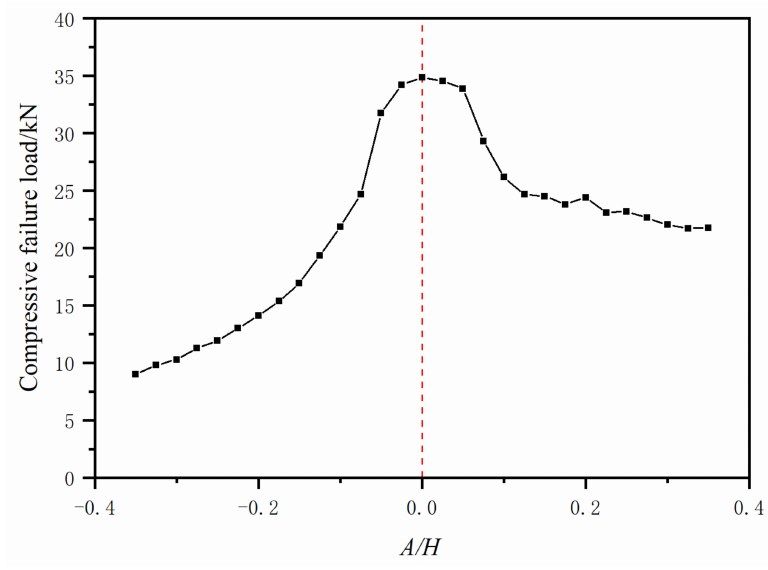
Figure 14. Compressive failure loads vs. aspect